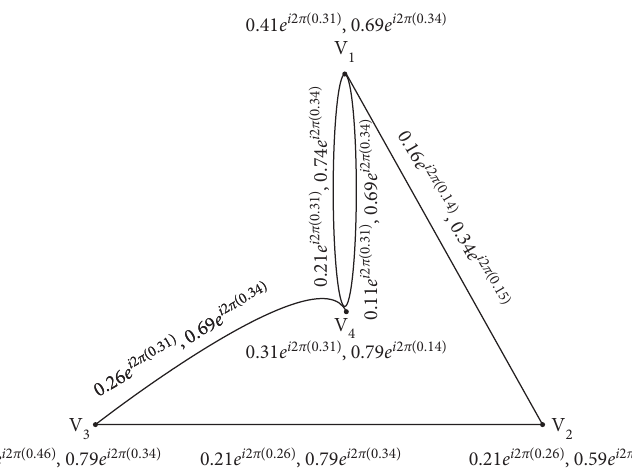
Figure 1: Complex q-rung orthopair fuzzy